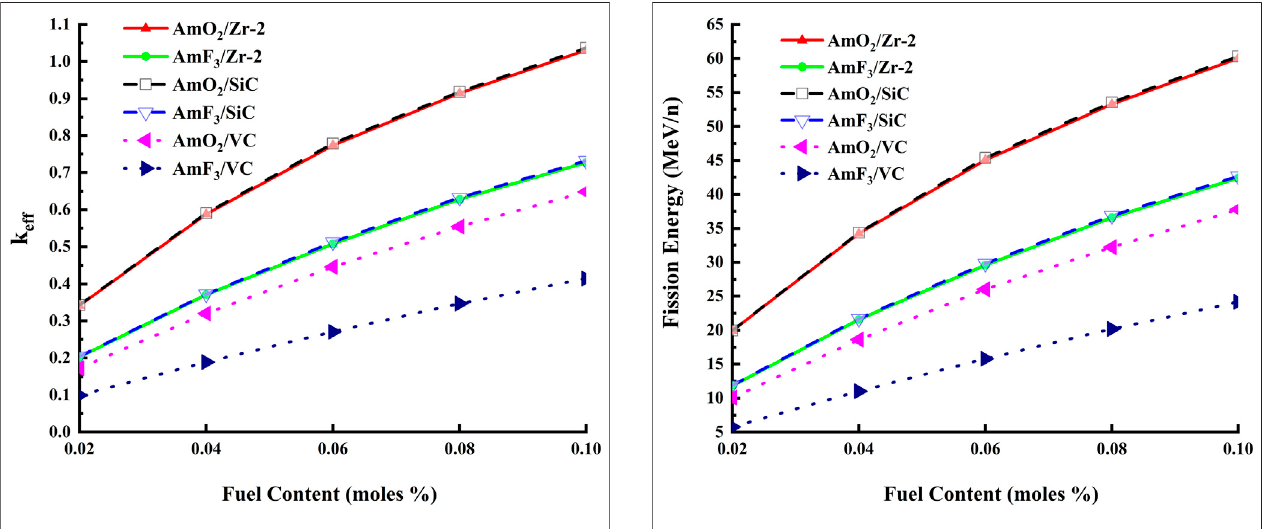
FIGURE 4 | The k eff values for Zr-2, SiC, and VC clads, the fuel components AmO 2 and AmF 3 in the BWR system.